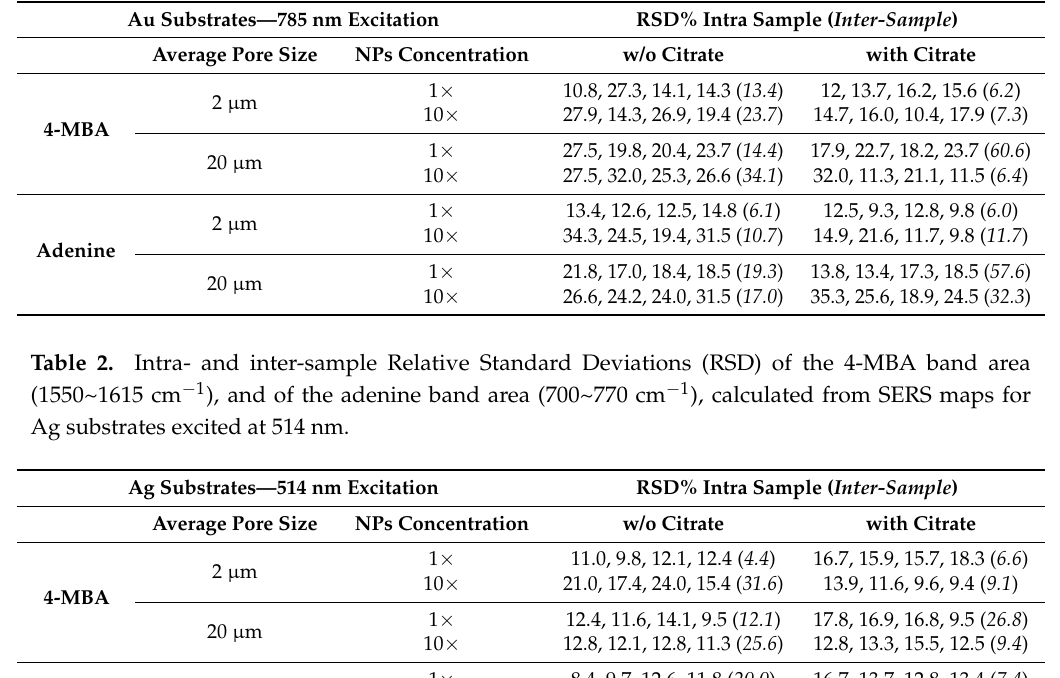
Table 1. Intra- and inter-sample Relative Standard Deviations (RSD) of the 4-MBA band area (1550~1615 cm − 1 ) and of the adenine band area (700~770 cm − 1 ) calculated from SERS maps for Au substrates excited at 785 nm.